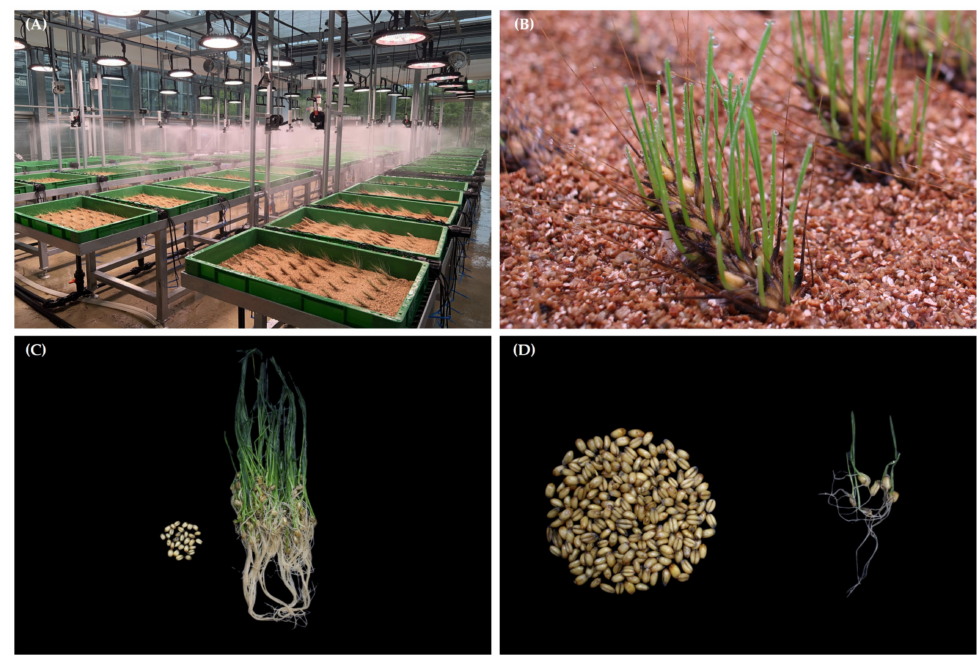
Figure 1. Phenotypic changes were induced in Keumgang and Woori spikes under pre-harvest sprouting (PHS) treatment. ( A ) The experiment was carried out for 7 days in an artificial growth control room to maintain optimal PHS induction conditions. ( B ) Wheat spikes on the 5th day of PHS induction; active germination is progressing by treatment. ( C ) Keumgang phenotype assay 7 days after PHS induction. ( D ) Woori phenotype assay 7 days after PHS